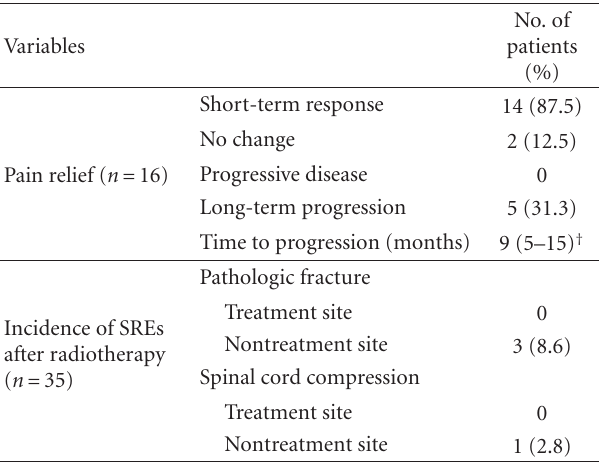
Figure 2: The overall survival curves for oligo-recurrence group Figure 3: The progression-free survival curves for patients with ( n = 18) and oligometastases group ( n = 17). RTX, radiotherapy. bone pain who had pain relief response at 1 month after radiother- apy ( n = 14) and with received total radiotherapy dose of ≥ 40 Gy ( n = 7) and < 40 Gy ( n = 7). RTX, Table 3: Treatment outcomes.